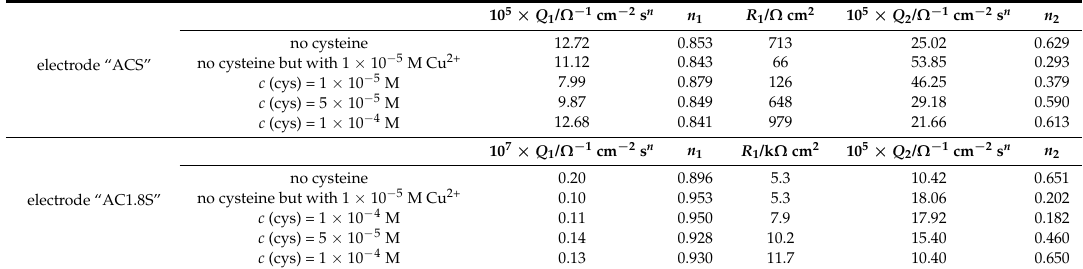
Table 1. Impedance parameters for electrodes “ACS” and “AC1.8S” (spectra recorded at pH 5), determined using the equivalent circuit, are presented in Scheme